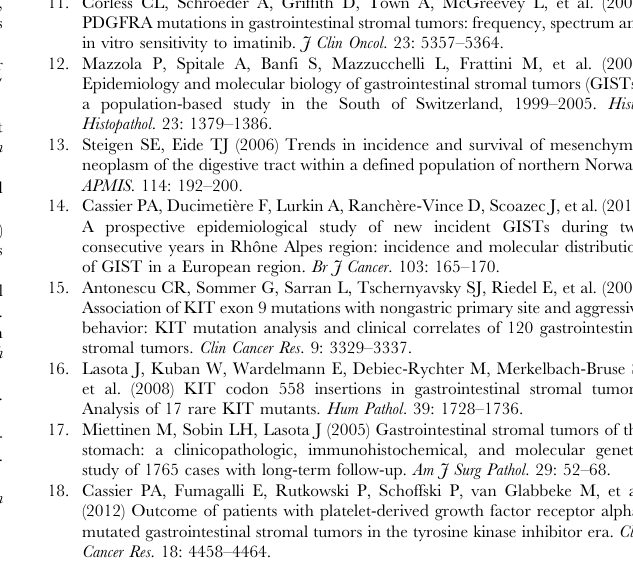
Table S1 Minor allele frequencies (MAF) and p-values for comparison of genotype frequencies: Z9001 geno- typed whites (n= 273) versus non-whites (n = 58) and genotyped Z9001 whites versus the HapMap CEU population (n= 180). Table S2 Minor allele frequencies (MAF), Odds Ratios (ORs) and association p-values by mutation type. Table S3 P-values for sequence kernel association test (SKAT) for remaining genes, by mutation